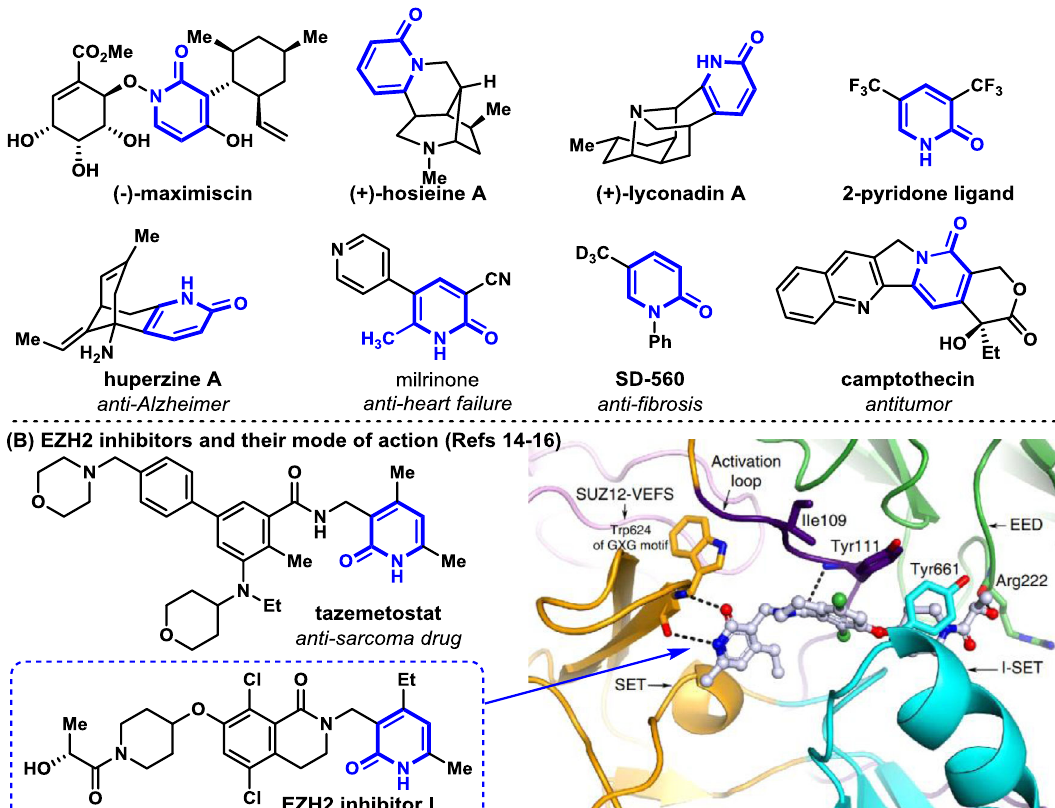
Fig. 1 2-Pyridone units in natural products, ligands, and pharmaceuticals. A Structurally related natural products, ligands, and pharmaceuticals. B EZH2 inhibitors and their mode of